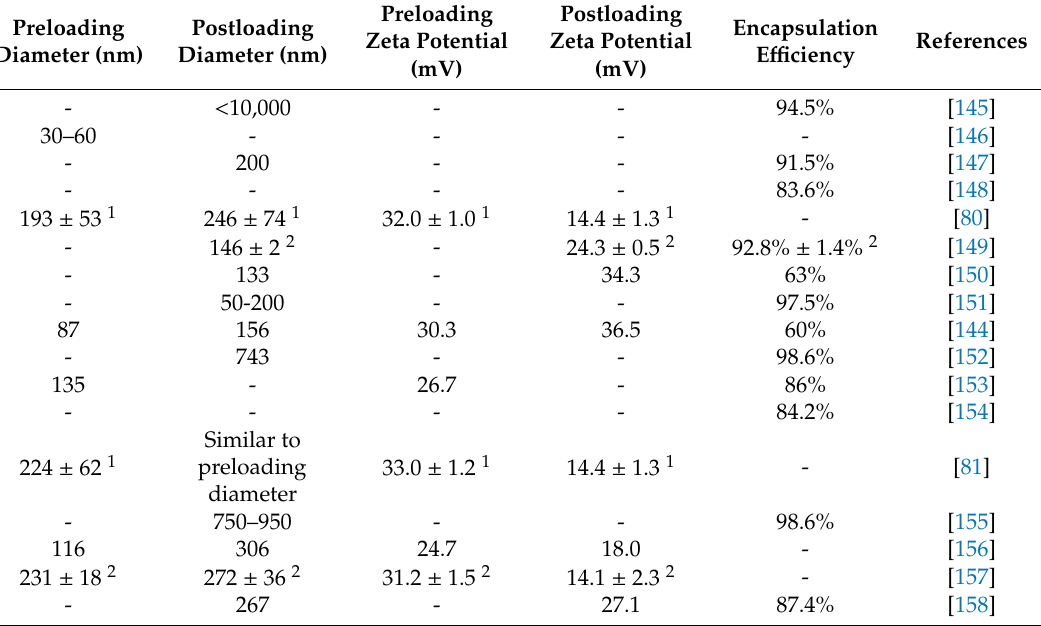
Table 1. Characteristics of chitosan–plasmid DNA polyplexes for studies performed in